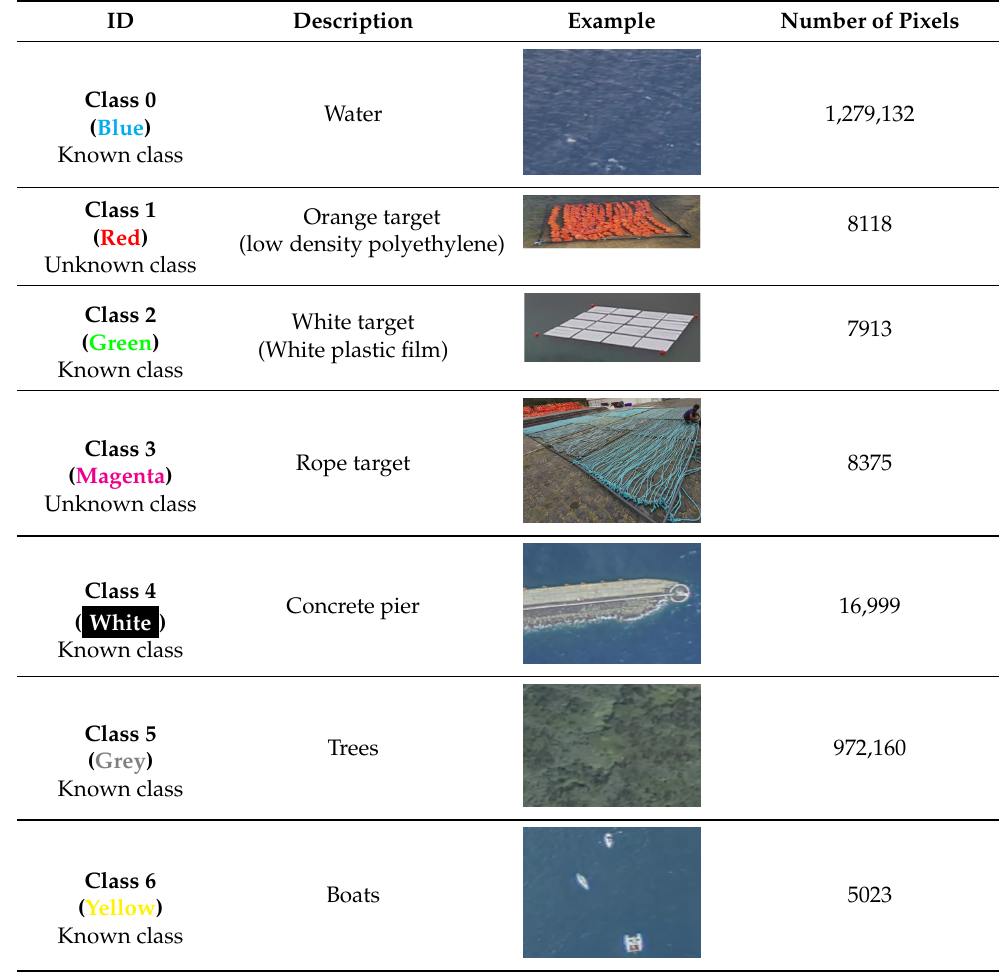
Table 1. Classes used for the ZSL algorithm, and main characteristics, e.g., description, known and unknown information, image and number of